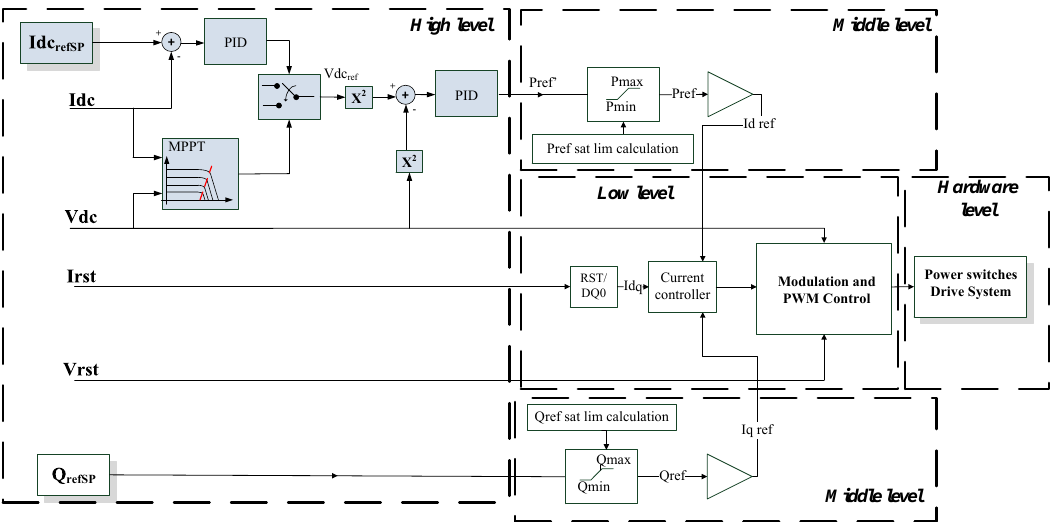
Figure 3. Main control diagram of a photovoltaic (PV) inverter controller: in blue are marked the high-level control blocks related to the maximum power point tracking (MPPT) and electroluminescence (EL) evaluation working